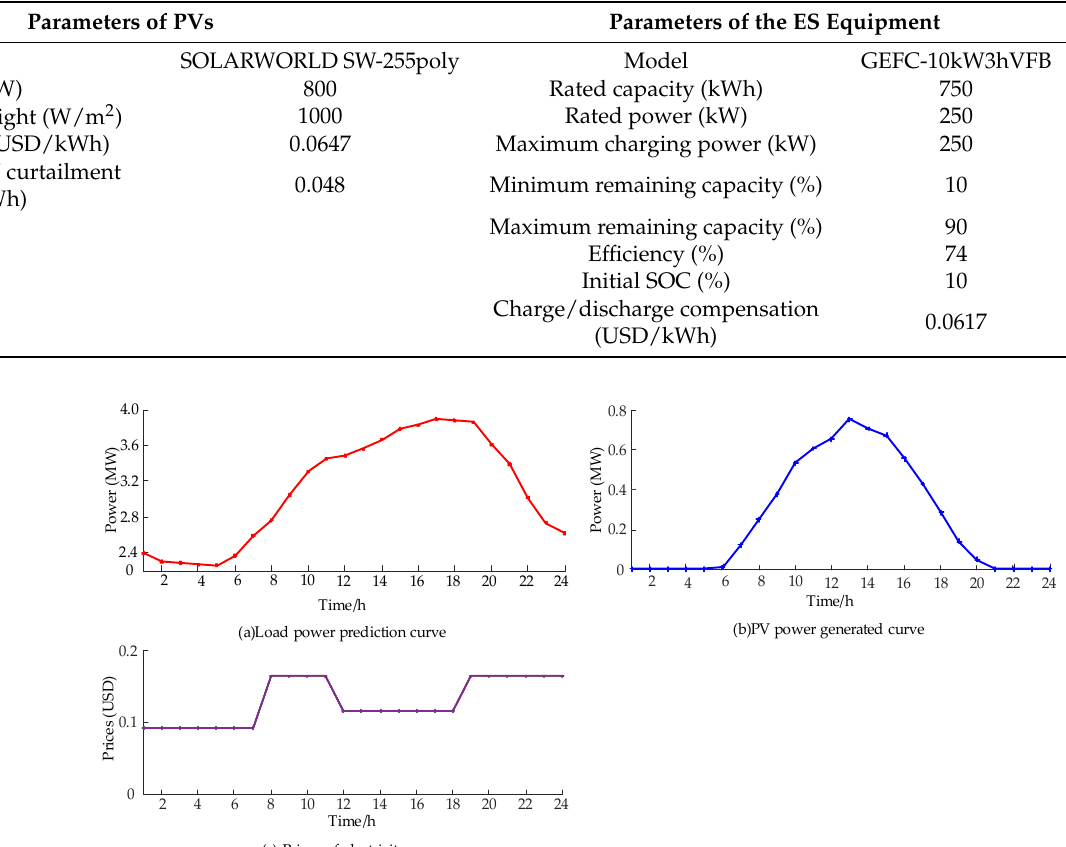
Table 3. Parameters of distributed energy sources.